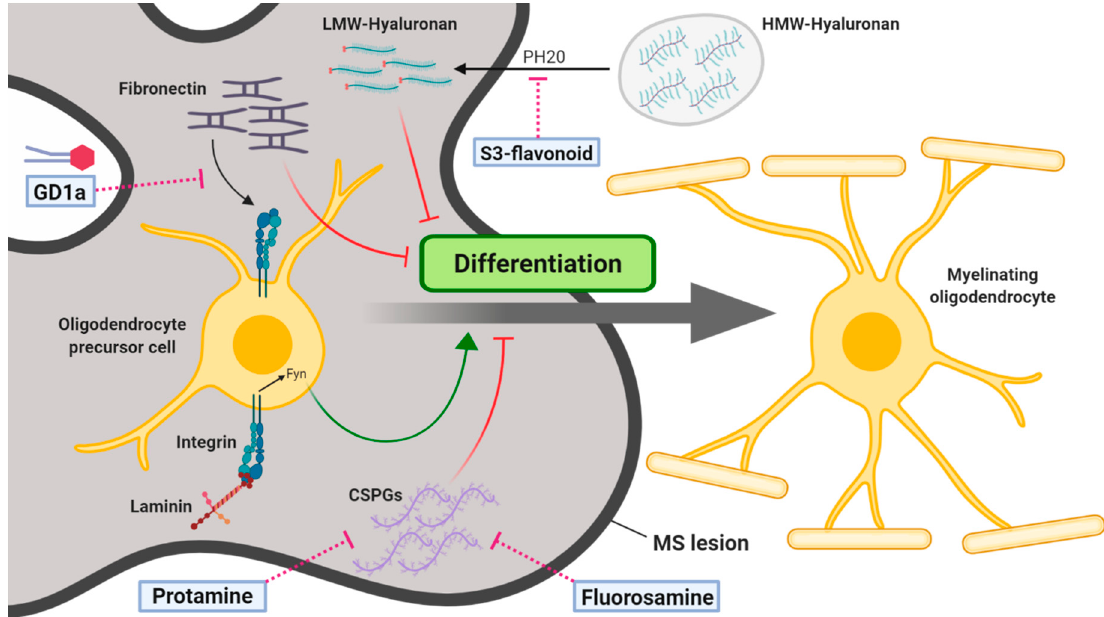
Figure 3. Targeting of extracellular matrix components to foster oligodendrocyte maturation and remyelination. In MS lesions, an unbalance expression of extracellular matrix components (fibronectin, hyaluronan, CSPGs) contributes to form a non-permissive barrier at the lesion edge, blocking the migration of oligodendrocyte precursor cells (OPCs), their maturation and the subsequent remyelination process. The differentiation of OPCs to myelinating oligodendrocytes can be enhanced by pharmacological agents (GD1a, S3-flavonoid, Protamine, Fluorosamine) that counteract the synthesis and accumulation of these factors. MS, multiple sclerosis, LMW, low molecular weight; HMW, high molecular weight; CSPGs, chondroitin sulfate proteoglycans.